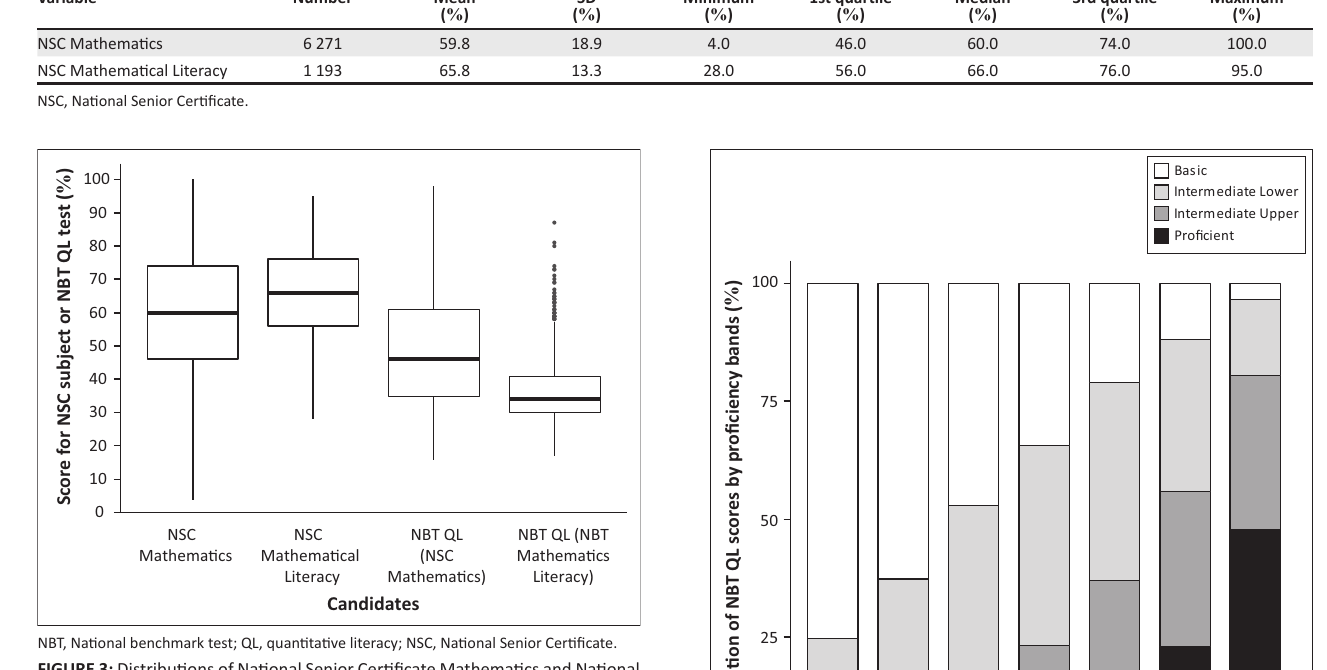
TABLE 8: Descriptive statistics for the National Senior Certificate Mathematics and Mathematical Literacy results for the whole sample ( N = 7 464) . Variable Number